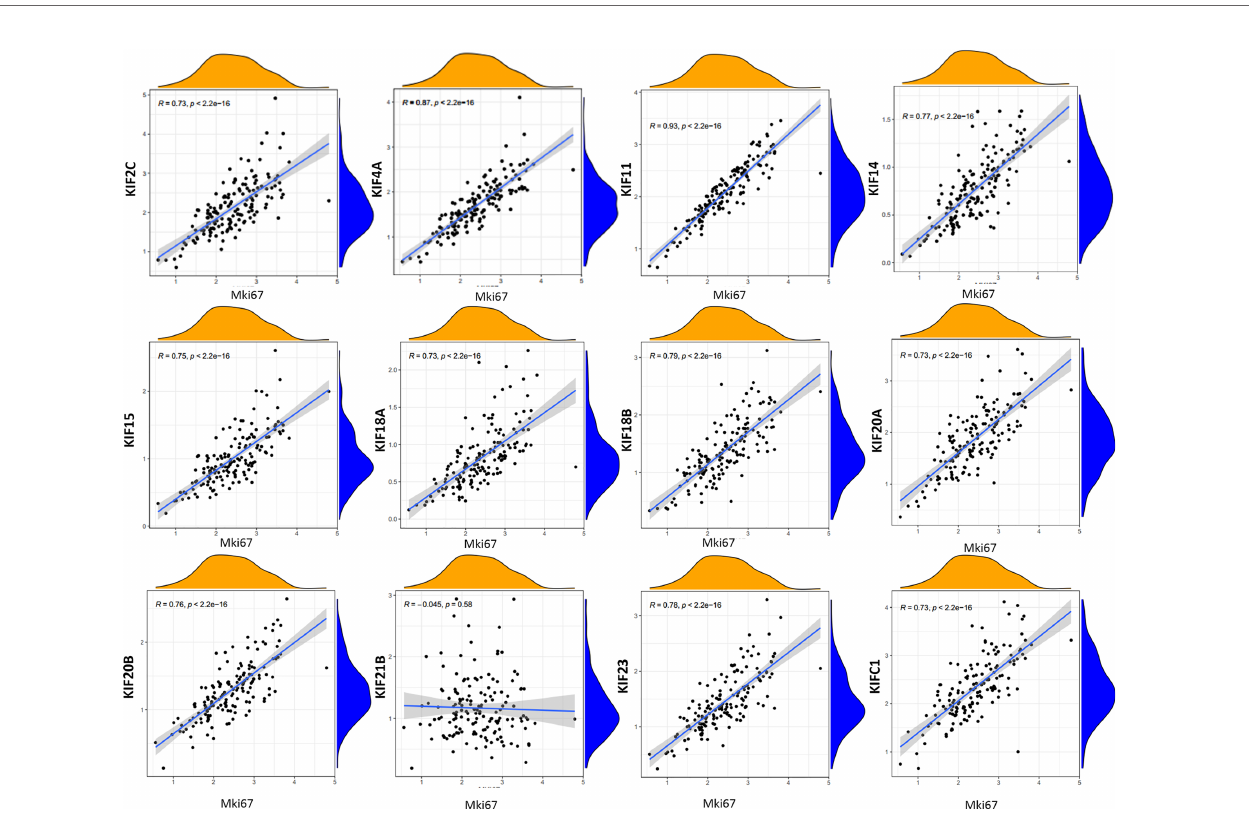
FIGURE 6 | Correlation between prognosis-related KIFs expression and tumor growth. Scatter plot was presented to display the correlation between prognosis- related KIFs expression and Mki67. Pearson test was employed to evaluate the correlation coef fi cients. Pearson r > 0 mean positive correlation, Pearson r <0 means negative correlation. Pearson r = 0 means no correlation between two genes. p < 0.05 is considered to be statistically different.